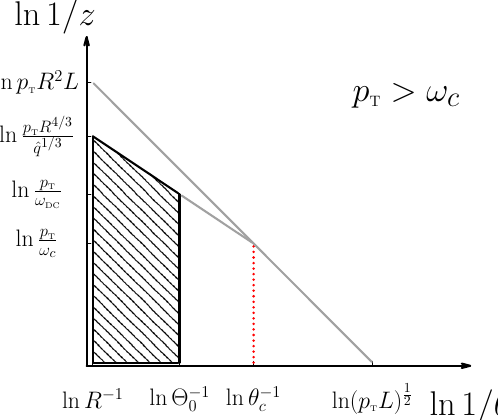
(lower line with slope − 4 / 3).The diagrams are drawn for the two cases: p T > ω c and R > (cid:2) 0 > θ c (left) and p T < ω c and R > (cid:2) 0 > θ d